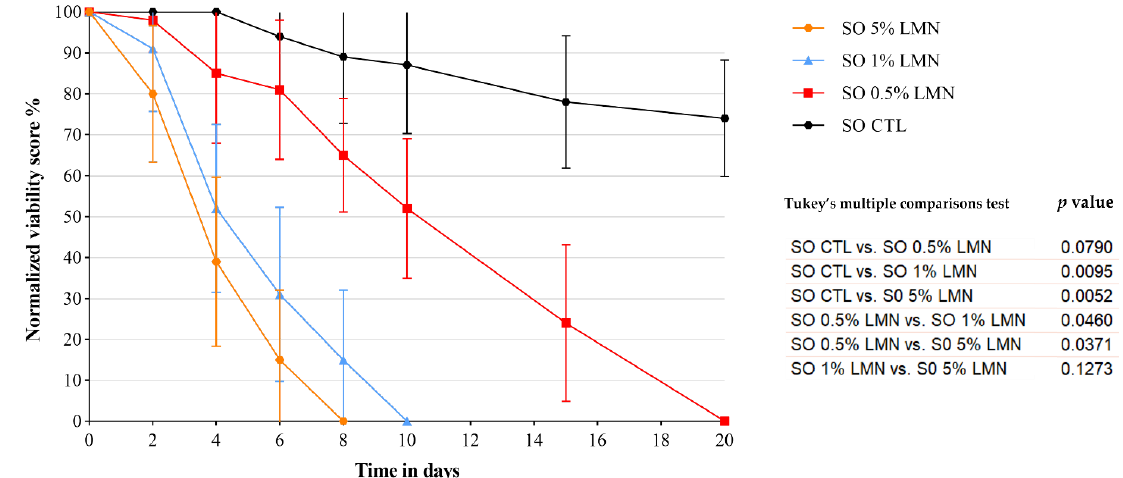
Figure 3. SO-Treatment 2: normalized mean viability score (%) over time of Anisakis larvae experi- mentally parasitized in anchovy fillets treated with different R (+) limonene (LMN) concentrations (5%, 1%, 0.5%) during storage in sunflower seed oil and relative control (CTL) without LMN. The results of the statistical analysis performed for the different treatments are also reported.